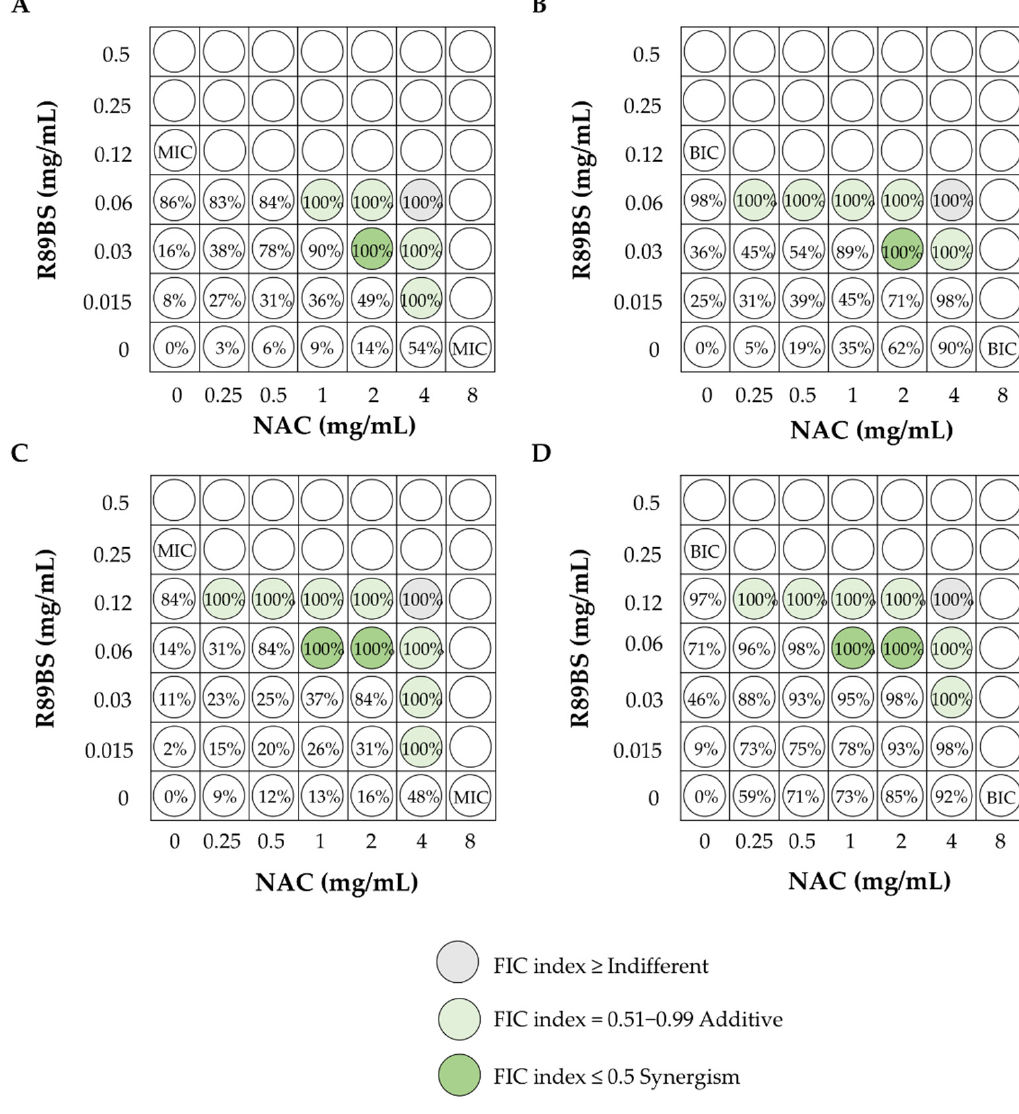
Figure 4. Representation of the results obtained by the Fractional Inhibitory Concentration (FIC) checkerboard assays for the determination of the synergistic activity of R89BS and NAC against the planktonic ( A , C ) and sessile cells ( B , D ) of the S. aureus ( A , B ) and S. epidermidis ( C , D ) clinical isolates. NAC: N -acetylcysteine; MIC: Minimum Inhibitory Concentration; BIC: Biofilm Inhibitory Concentration.